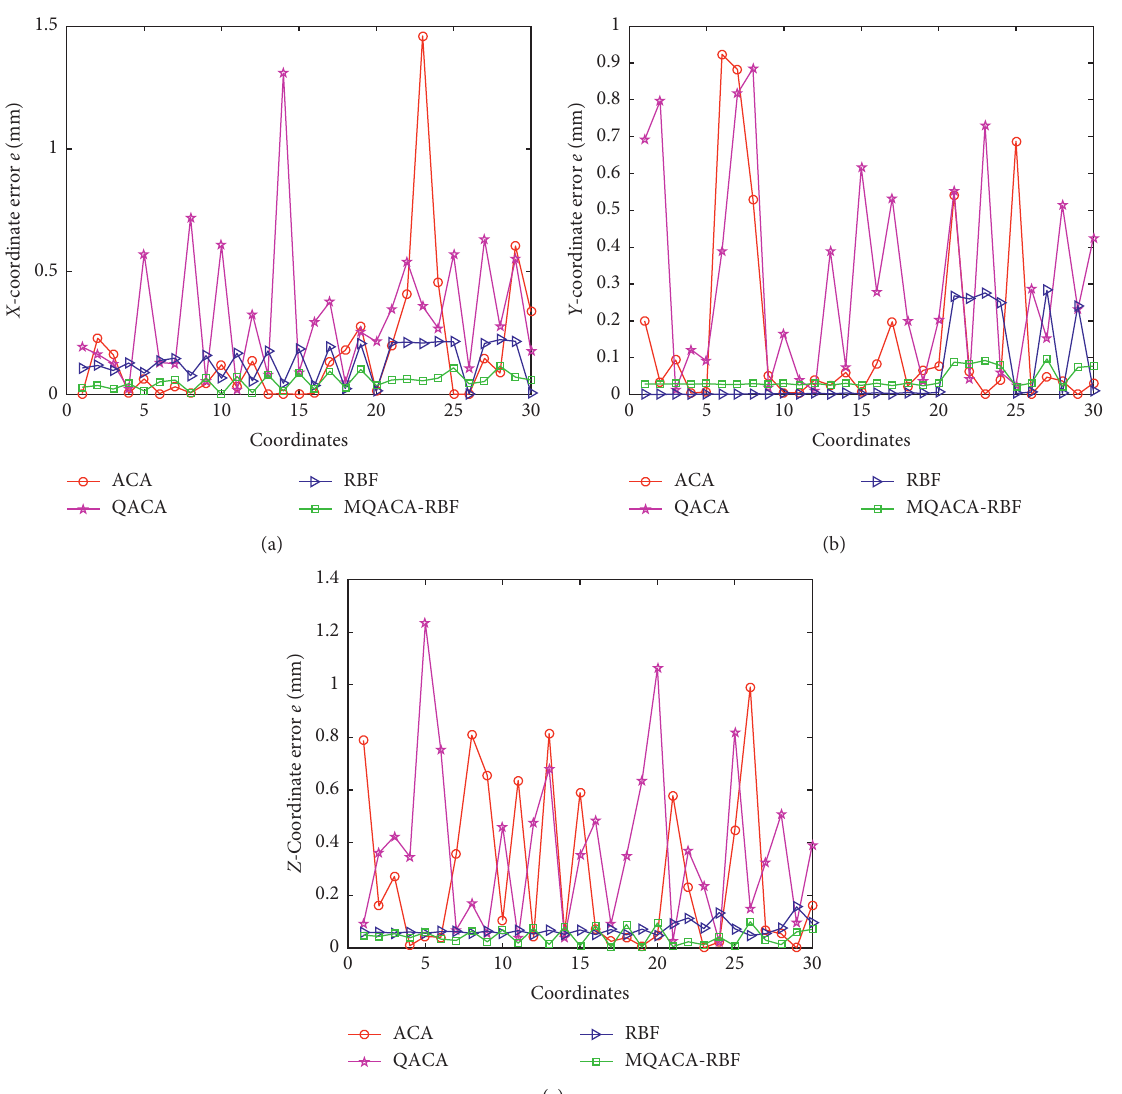
Figure 9: Comparison of coordinate errors of the selected points. (a) X -coordinate error comparison. (b) Y -coordinate error comparison. (c) Z -coordinate error comparison.